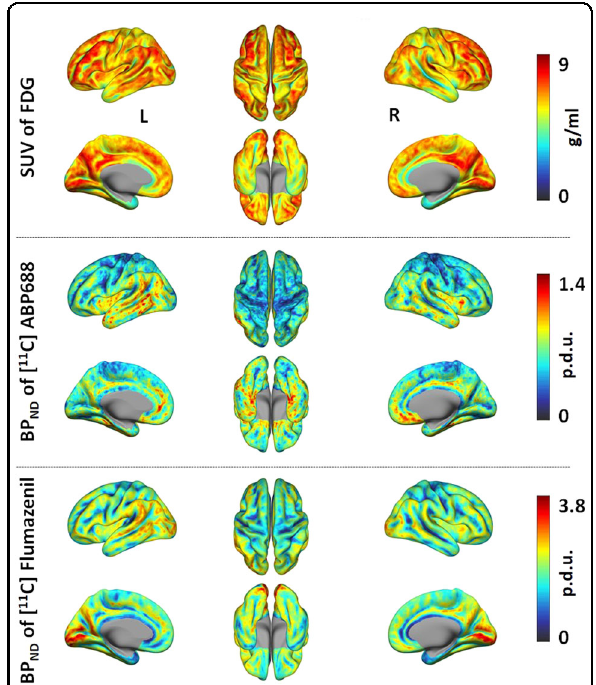
Fig. 1 PET parametric images. The 3D images representing the SUV of the FDG tracer are shown in the top row; the BP ND of ABP and FMZ are shown in the middle and bottom rows. The SUV images show glucose consumption in g/ml, the BP ND images show the distribution of the neuroreceptor availabilities for mGluR5 (middle row) and GABA A (bottom row) receptors in procedure de fi ned unit (p.d.u.). The calculated PET parametric images, averaged across all subjects in each study, are presented. The left, superior and right views are shown in the upper rows and left medial, inferior and right medial views are shown in the lower rows of each parametric